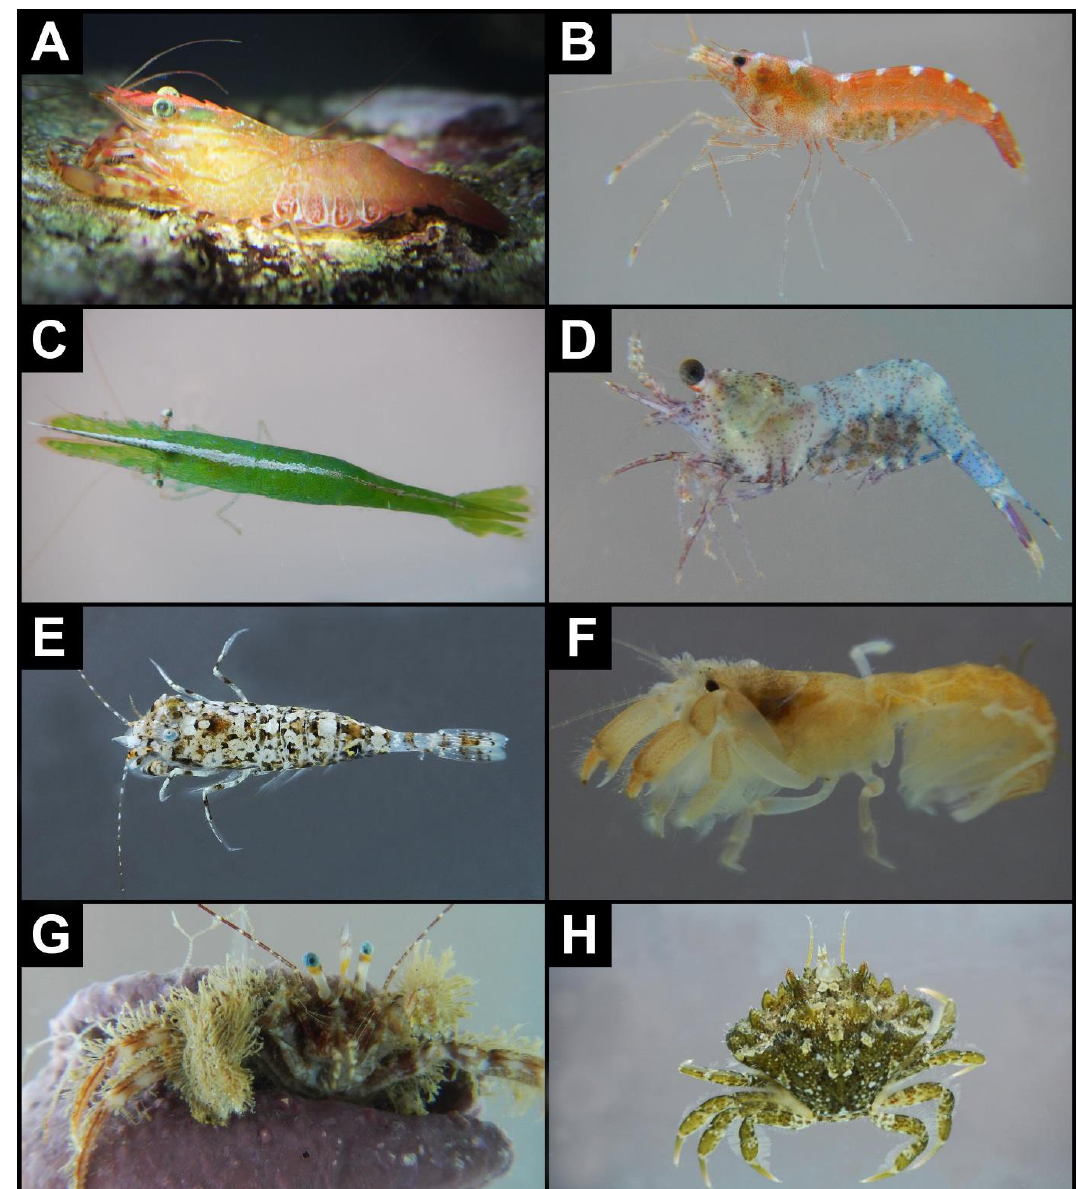
Figure 2. Decapods from Rhodes area, in colours. ( A ) Brachycarpus biunguiculatus , not measured; ( B ) Athanas nitescens , CL 3.3 mm; ( C ) Hippolyte inermis , CL 2.6 mm; ( D ) Eualus cranchii , CL 2.1 mm; ( E ) Philocheras trispinosus , CL 4.0 mm; (F) Upogebia deltaura , CL 5.0 mm; ( G ) Pagurus cuanensis , SL 4.2 mm; ( H ) Pirimela denticulata , CL 13.3 mm.